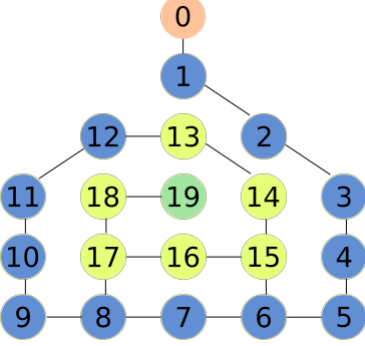
Figure 4. Enumerating the